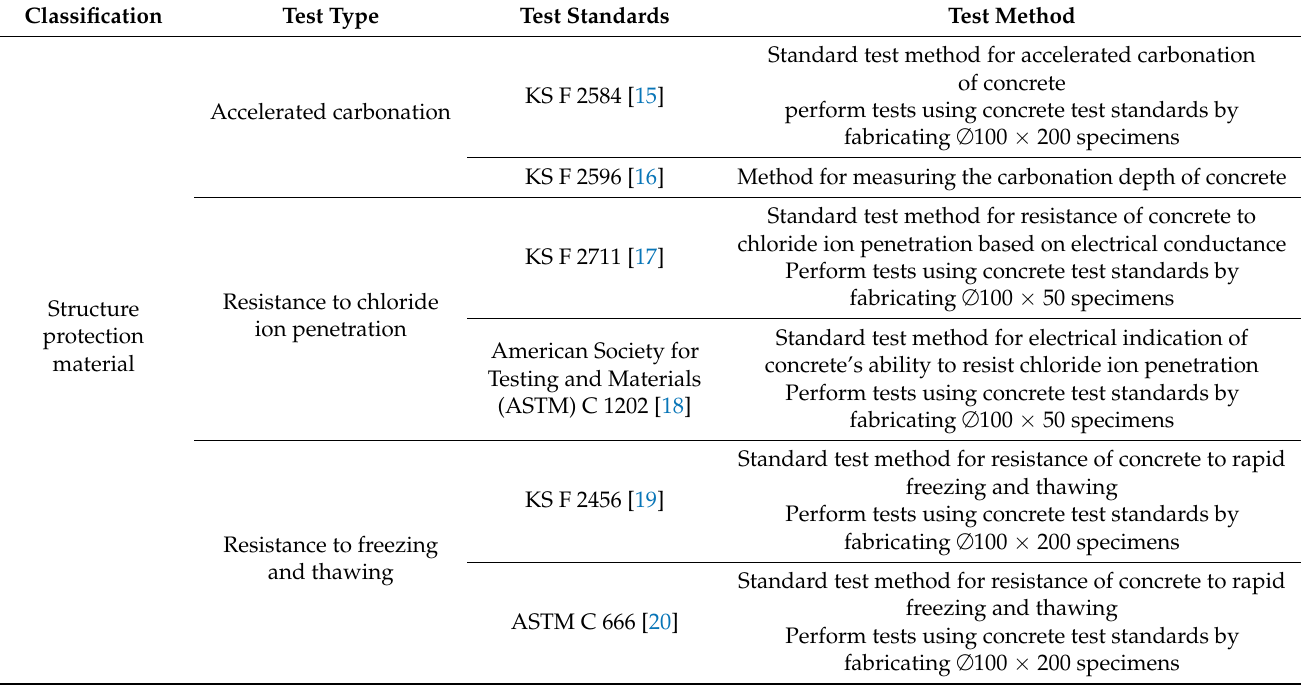
Table 4. Test standards and methods for structure protection material [15–20].